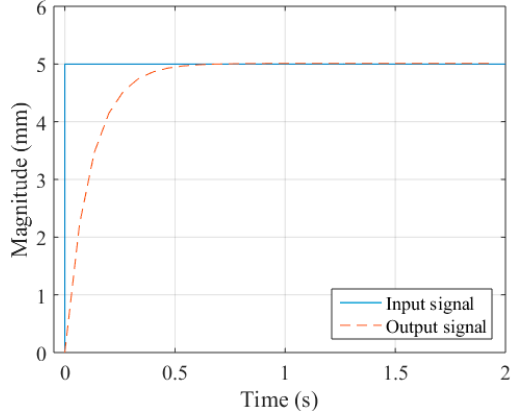
Figure 24. The step response of the proposed control system.